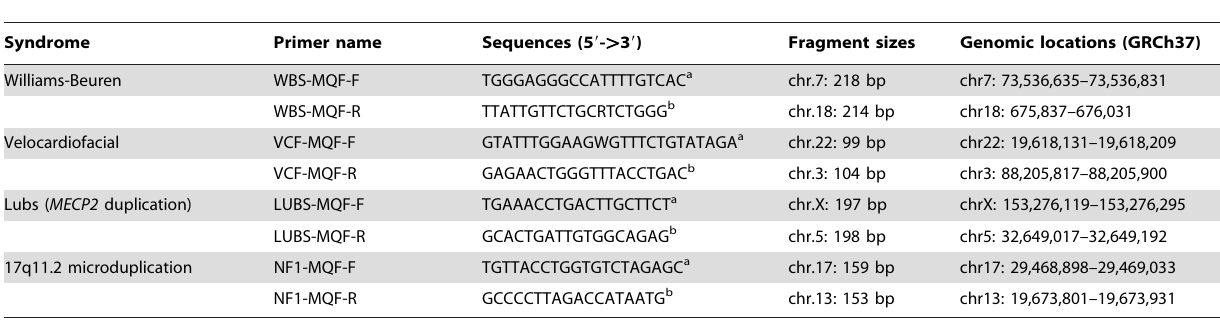
Table 2. MQF-PCR primers used in detection of microdeletion and microduplication